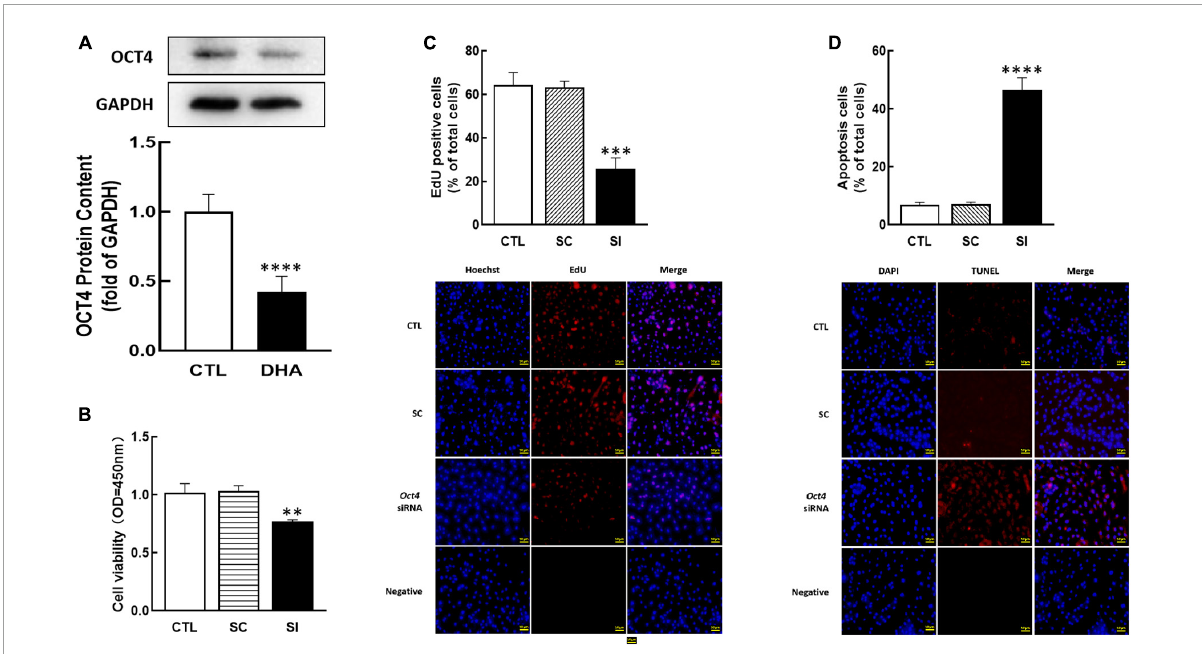
FIGURE3 Effect of Omega-3 on OCT4 expression and the effect of Oct4 siRNA on KGN cells development. The cells were treated with omega-3, and OCT4 protein content was detected by Western blot (A) . After transfected with Oct4 small interfering (SI) RNA (scrambled sequence as control, SC) for 48 h using Lipofectamine 3000, the cell viability (B) , proliferation (C) , and apoptosis (D) were analyzed by CCK-8 assay, EdU and TUNEL measurement, respectively. Data are presented as mean ± SEM of three independent experiments. ∗∗ P < 0.01, ∗∗∗ P < 0.001, ∗∗∗∗ P < 0.0001 compared with CTL. Bar = 50 µ m.